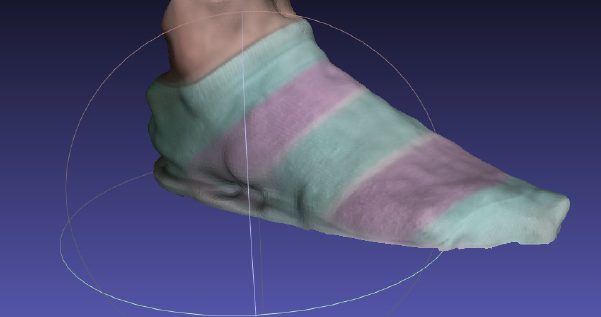
Figure 7. The 3D reconstruction foot model.